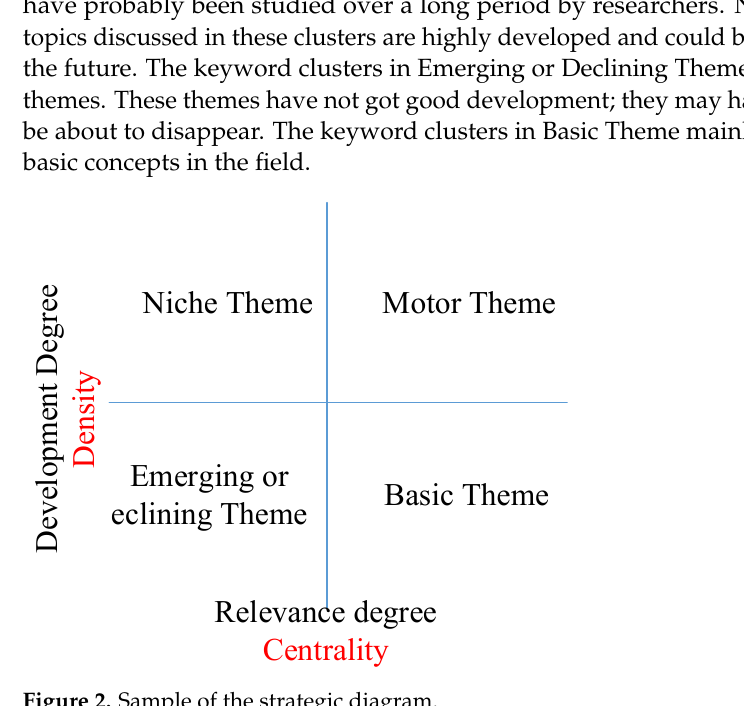
Figure 2. Sample of the strategic diagram.